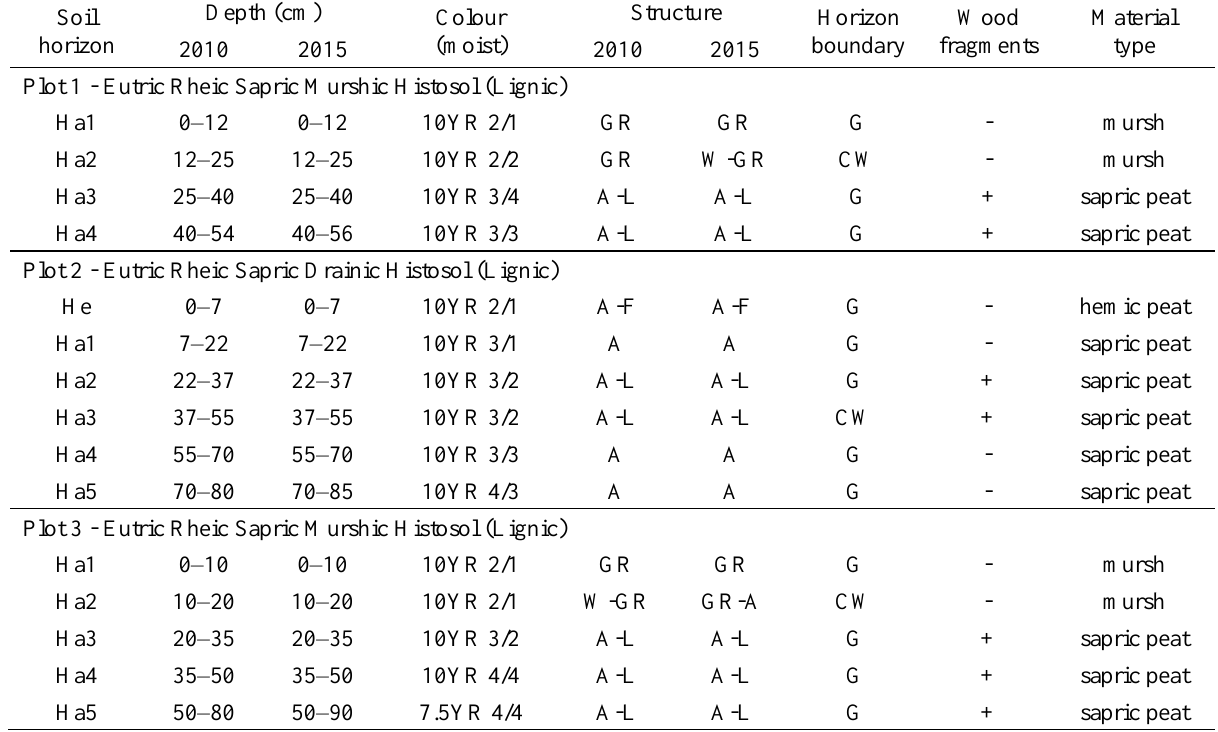
Table A1. Morphology and classification of the soil profiles at the three sampling plots. For ‘Structure’: A = amorphous, GR = granular, L = lumpy, F = fibrous, W = weak. For ‘Horizon boundary’: G = gradual, C = clear, W = wavy.